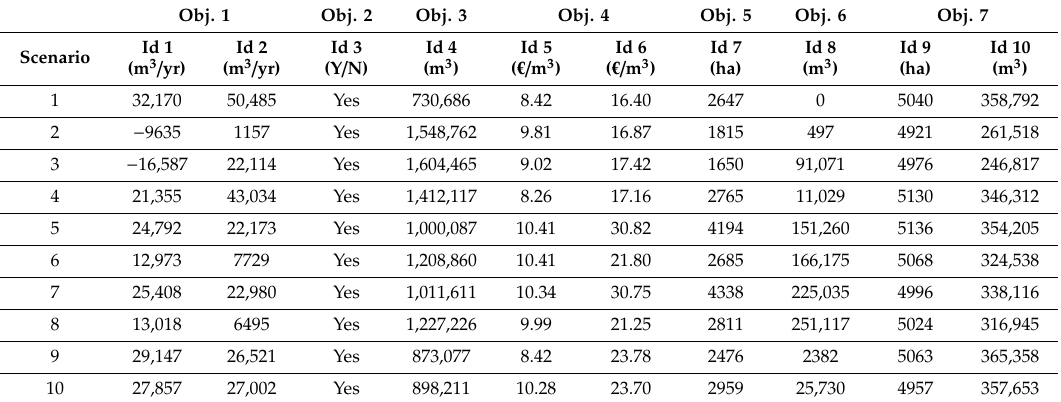
Figure 7. Standing volume (m 3 ) in the study area over the 20-yr simulation period in the first simulation for all scenarios considering broad volume goals (Table A4, Appendix C). Table 4. Forest biomass assessment indicators outputs for the first simulation using initial volume goals in each industry / scenario (Table A4, Appendix